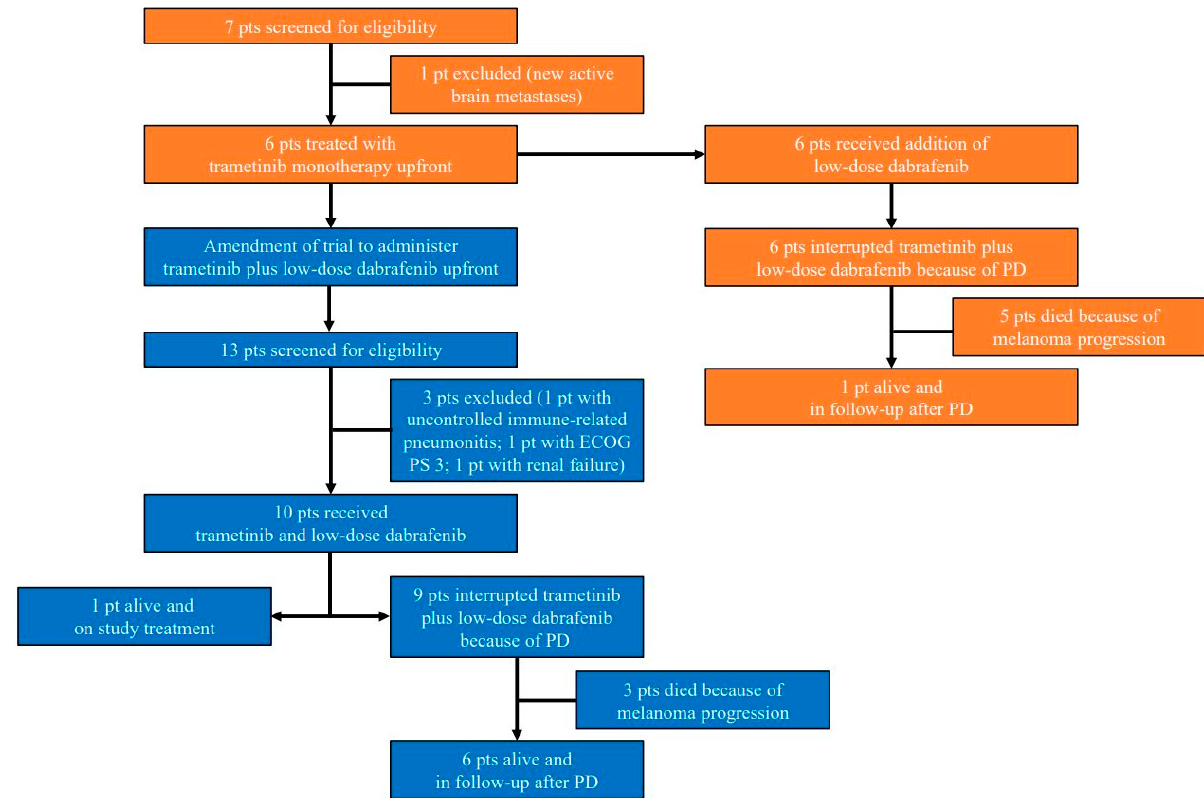
Figure 1. CONSORT-diagram. Patients enrolled prior to the trial amendment are depicted in orange, patients enrolled after the trial amendment and who were part of the first stage of the study are depicted in blue. Abbreviations: ECOG PS: Eastern Cooperative Oncology Group Performance Status; PD: progressive disease; pt(s):